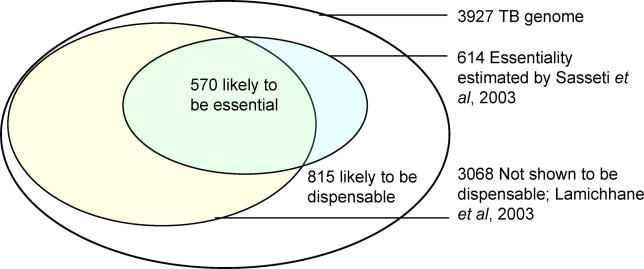
Overlap of M. tuberculosis Growth-Essential Genes